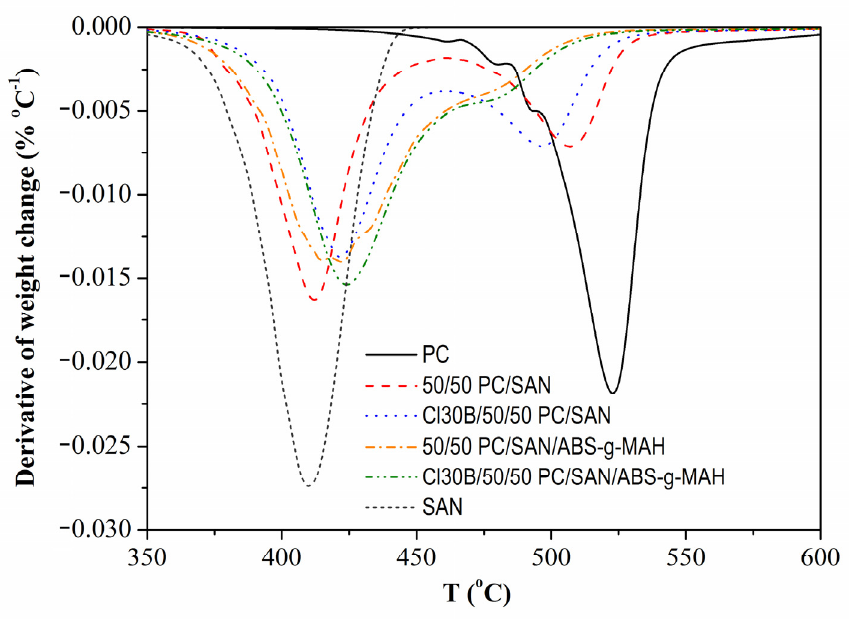
Figure 5. Derivative of weight change versus temperature for PC, SAN, and 50/50 w/w PC/SAN blends.